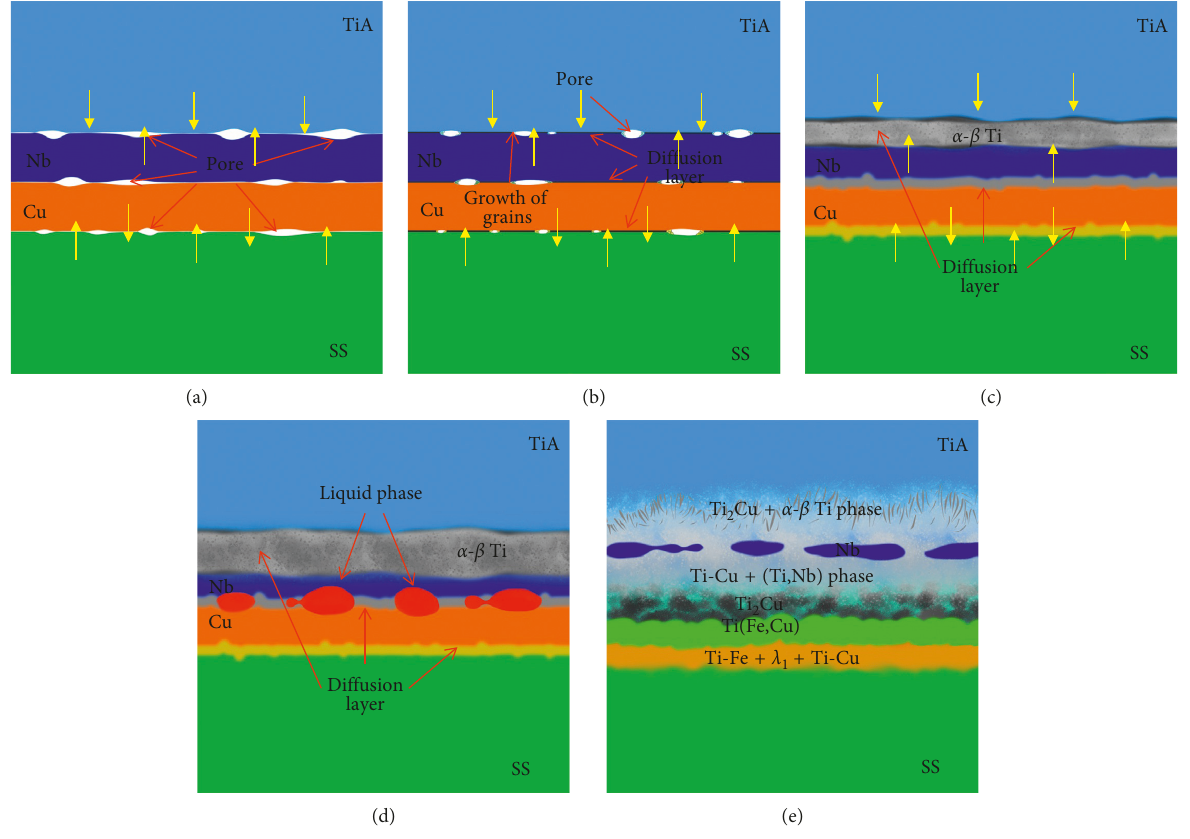
Figure 10: Formation process of titanium alloy and stainless steel diffusion-bonded joint using Cu/Nb multi-interlayer: (a) pores exist at the interface; (b) diffusion of atoms and growth of grains; (c) formation of α - β Ti and diffusion layers; (d) liquid phase formed at the interface; (e) formation of intermetallic